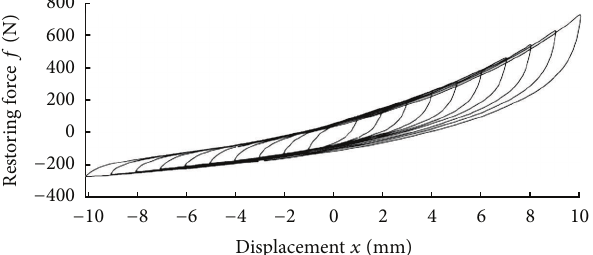
Figure 7: Asymmetrical cycles for tension-compression loading of a wire rope isolator [10].